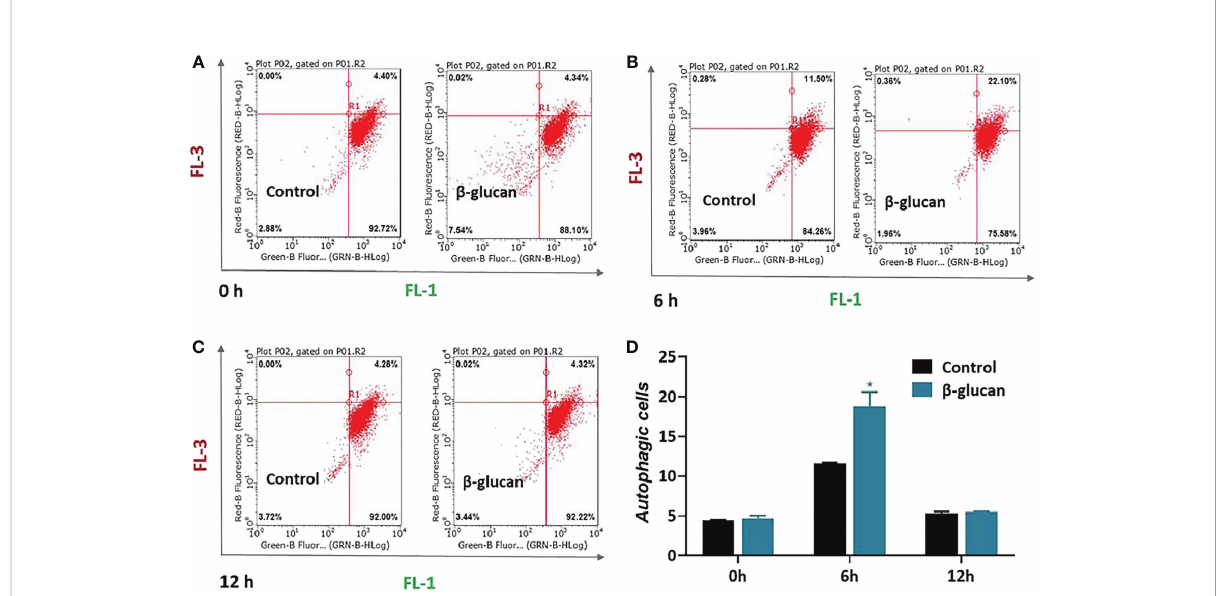
FIGURE 6 Effects of b -glucan on autophagy level in ZF4 cells. Autophagy was quanti fi ed by fl ow cytometry after AO staining. The fl ow cytometry results of control or b -glucan-treated ZF4 cells at 0 h (A) , 6 h (B) , and 12 h (C) post SVCV infection were exhibited; (D) Percentage of control or b -glucan- treated ZF4 cells positive for autophagosomes at different time points after viral infection. Values represent the means ± SEM. * P < 0.05 (n =